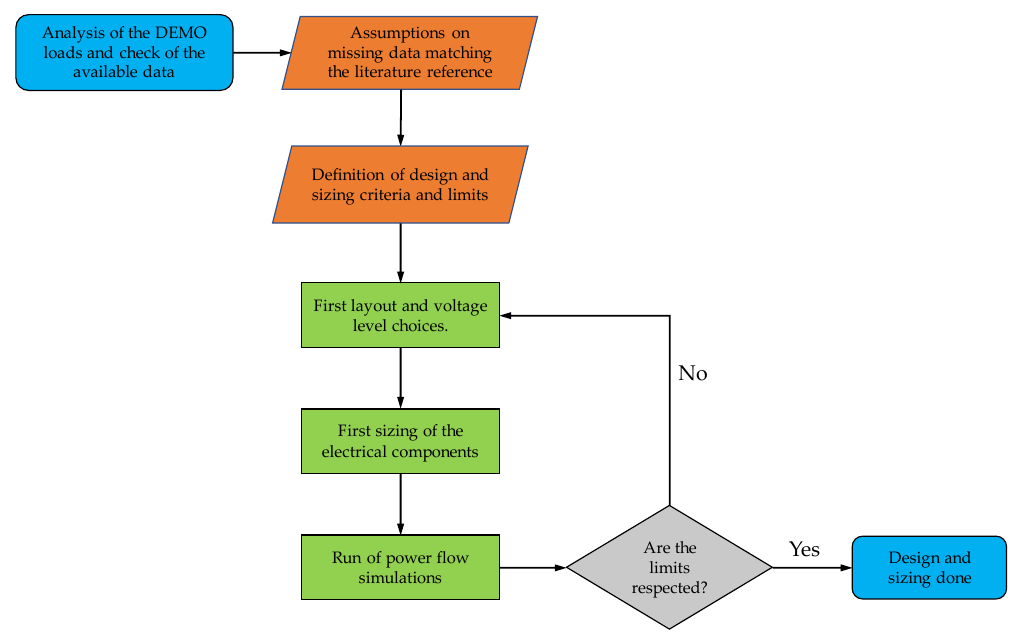
Figure 8. Simplified flow diagram of the algorithm adopted for the preliminary design of the DEMO SSEN.